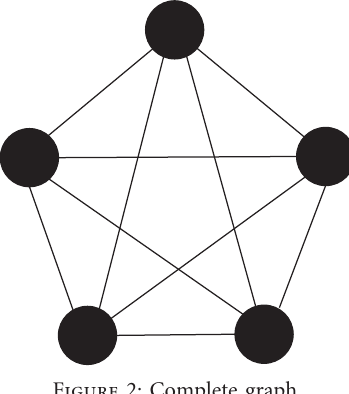
Figure 2: Complete graph.